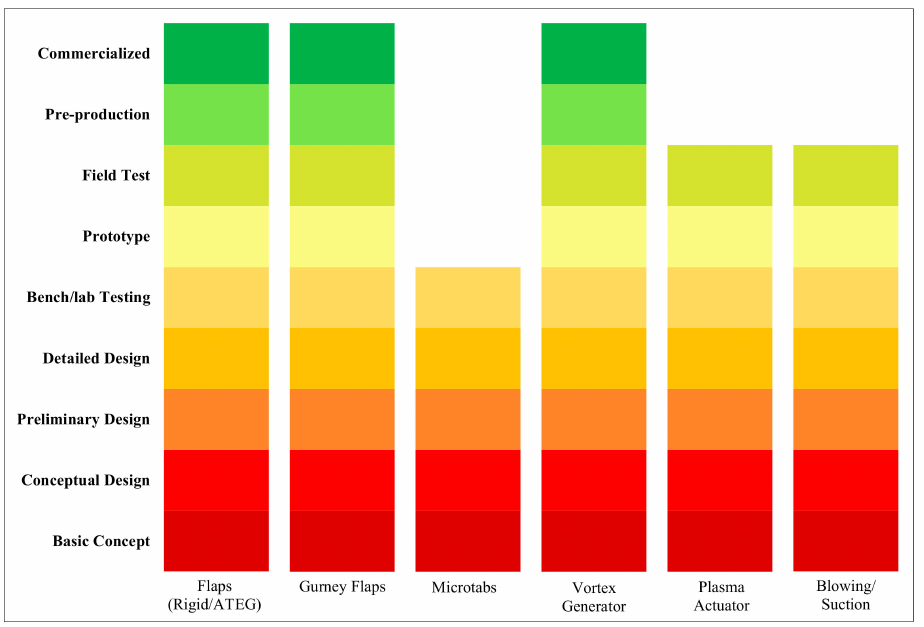
Figure 12. Technology Readiness Level (TRL) of various flow-control